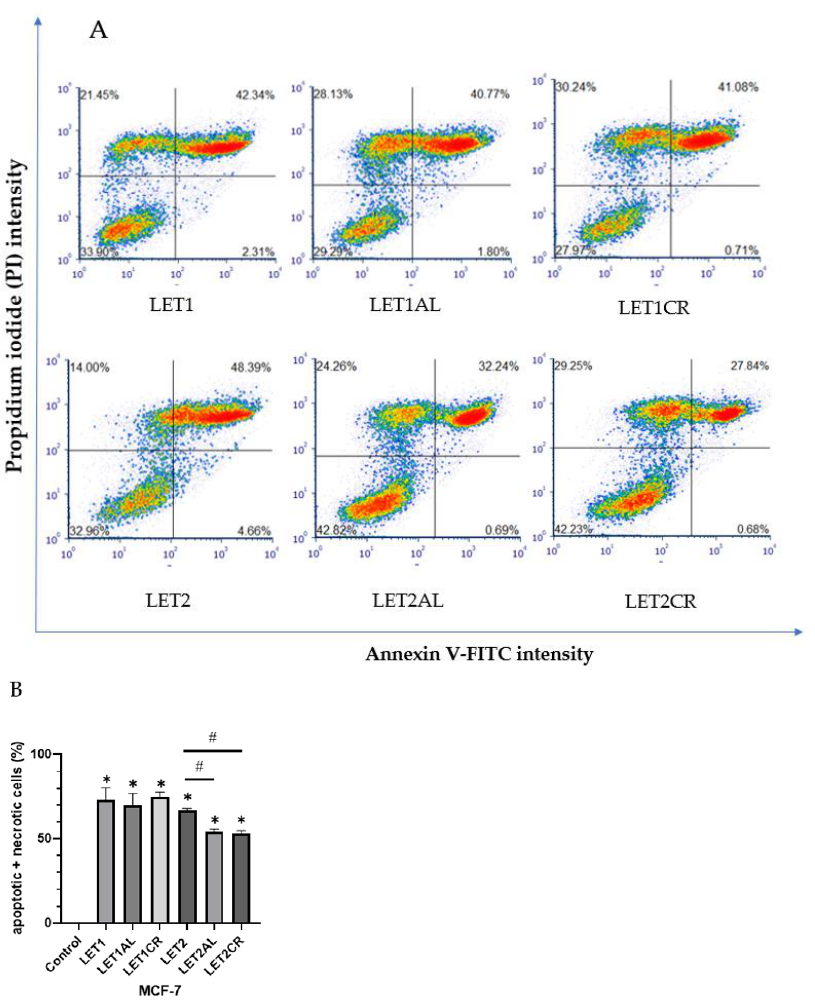
Figure 3. Effect of letrozole alone and in combination with metalloestrogens on MCF-7 cell death. ( A ) Representative cytograms of flow cytometric are shown. LET1 = 10 µM; LET2 = 100 µM; Al./Cr(III) = 100 µM. ( B ) Percentage of both apoptotic (early and late apoptotic) and necrotic cells. The results are presented as mean ± SD, n = 3; p < 0.05; * statistically significant difference from control; # statistically significant difference from aromatase inhibitor alone.